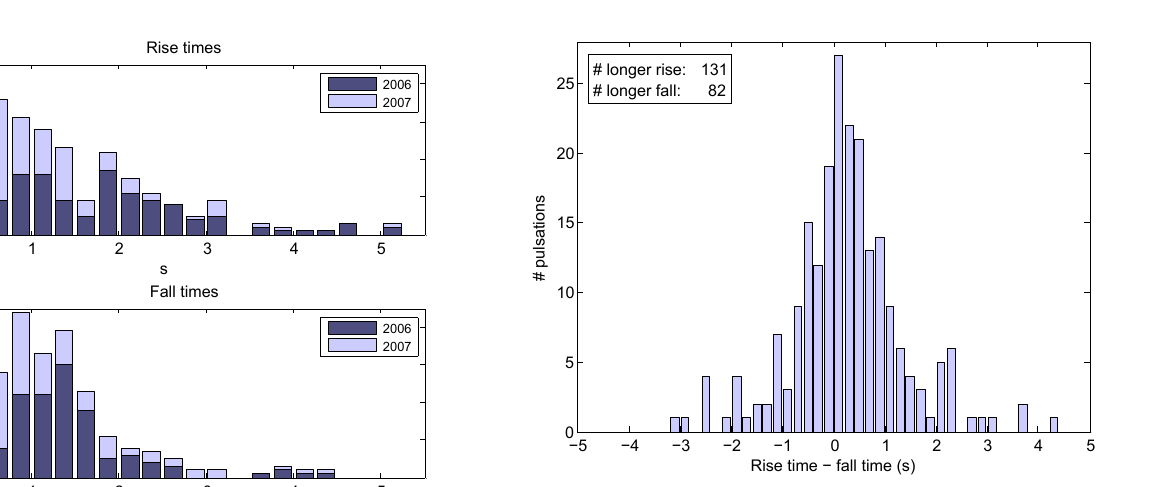
Figure 8. Distribution of the difference in rise and fall time for the